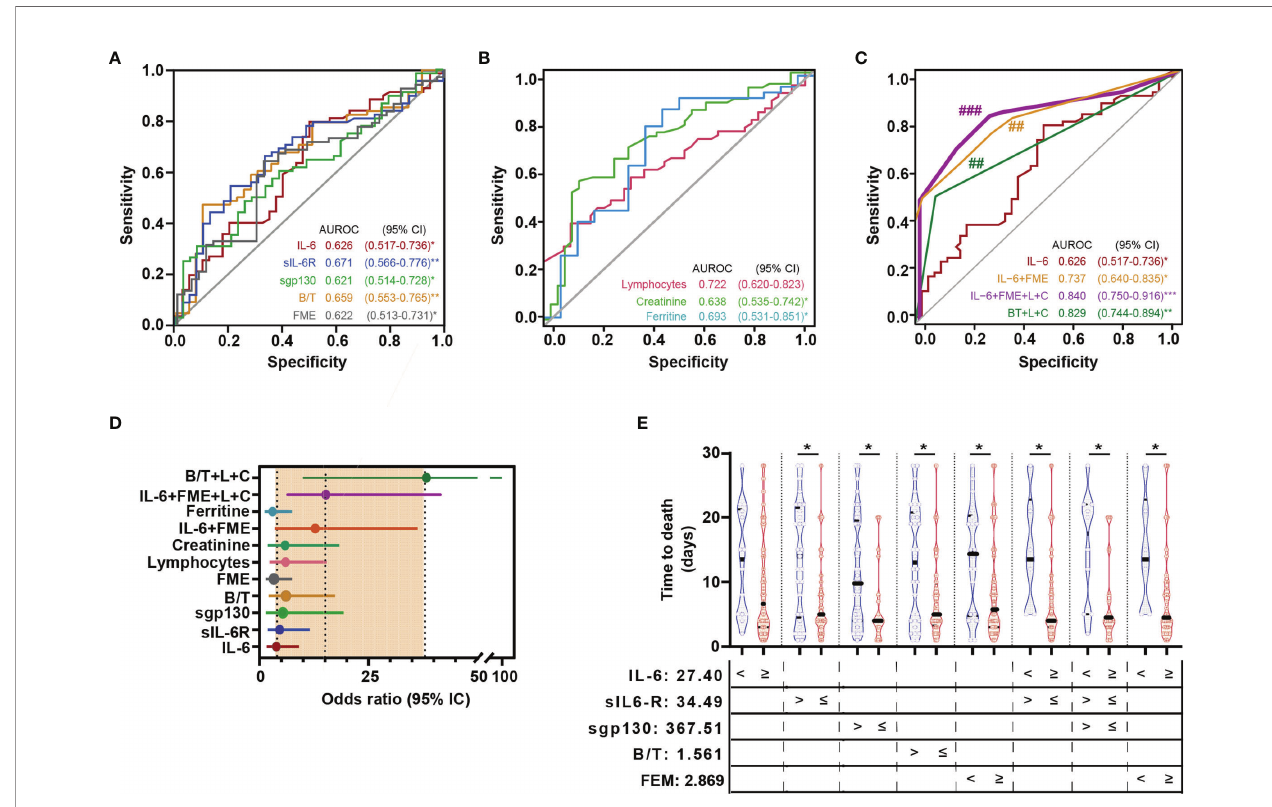
FIGURE 3 | IL-6 signalling biomarkers as predictors of mortality. AUROC curves (95% CI) of IL-6 signalling variables and biochemical data (A) and composed scores (B) . Statistically signi fi cant differences among ROC curves were evaluated using DeLong ’ s test. ## p < 0.01 vs IL-6 ROC curve. (C) Forest plots of OR summarizing the risk of death for each variable or proposed score. (D) Violin plots indicating time to death according with levels of IL-6, sIL-6R, sgp130, Binary/ Ternary complex ratio (B/T), and fold molar excess of sgp130 over sIL-6R (FME) above and below cut-off values. Each dot represents a sample; solid and dotted lines show the median and 95% CI, respectively. (L) lymphopenia and (C) creatinine. *** p < 0.001, *p < 0.05; **p < 0.01; ### p < 0.001 vs IL-6 ROC